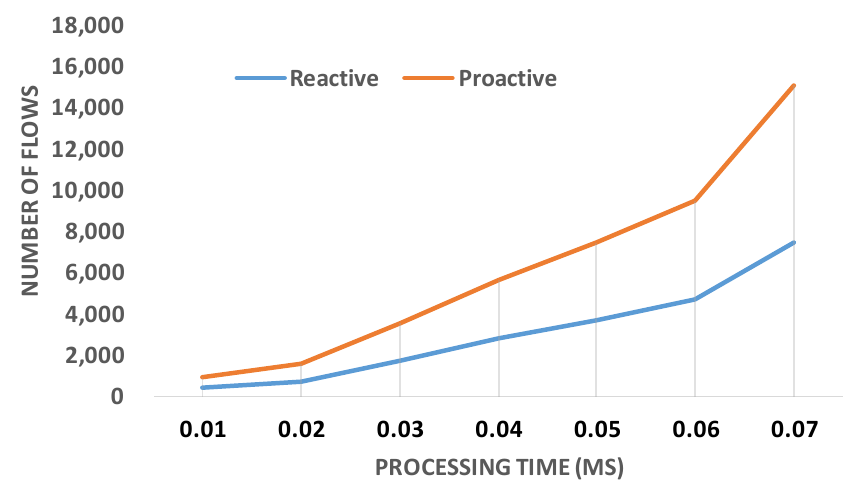
Figure 13. Two nodes ’ flow-rule exchange.